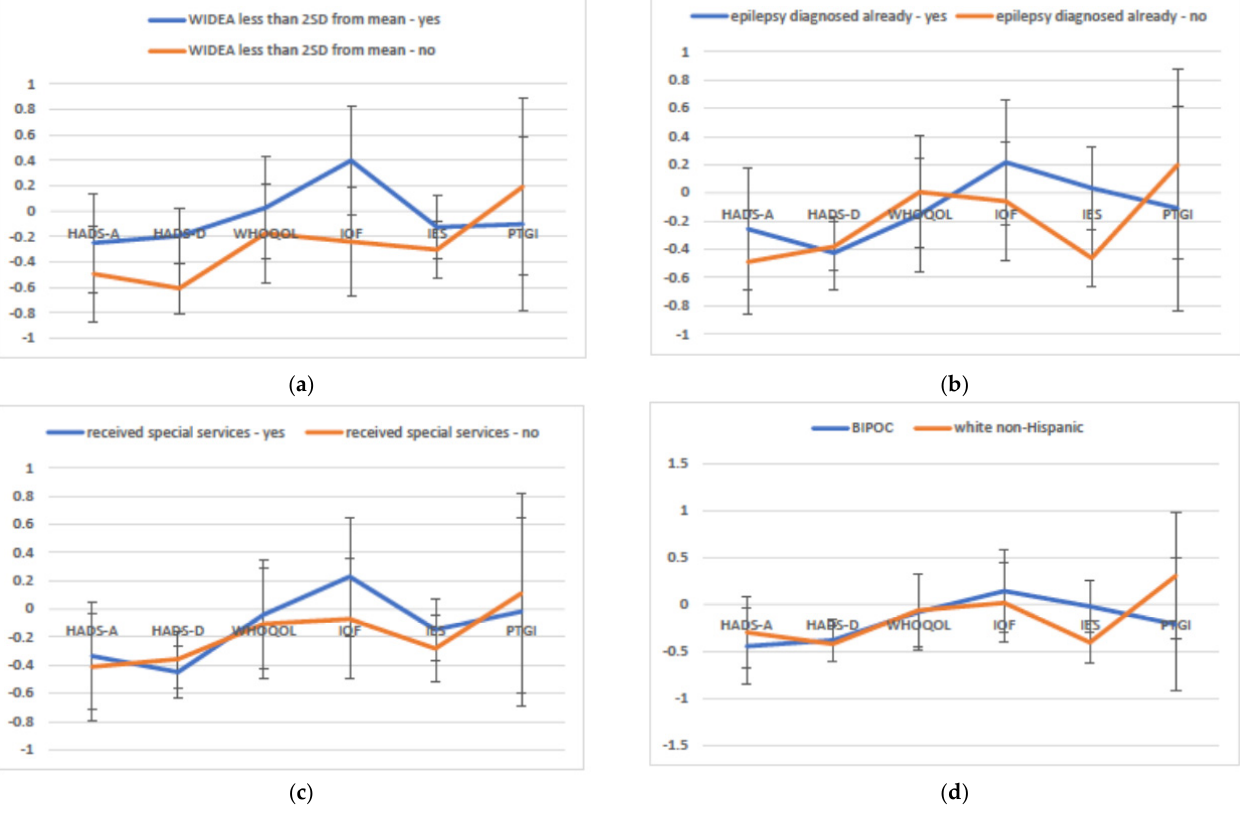
Figure 2. Adjusted mean Z-scores for the variables with significant interactions across the parent mental health and family coping outcomes. Note: The connecting lines are included to make it visually easy to see if the results are the same across outcomes (i.e., the lines are parallel) or if the ordering of the exposure groups changes (i.e., the lines cross). ( a ) Outcomes by child functional impairment (WIDEA-FS > 2 standard deviations below the mean) averaged over all time points ( p < 0.001); ( b ) Outcomes by child diagnosis of epilepsy averaged over all time points ( p < 0.0001); ( c ) Outcomes by child receiving developmental support services averaged over all time points (P = 0.002); ( d ) Outcomes by child race/ethnicity averaged over all time points ( p < 0.0002). HADS = Hospital Anxiety and Depression; IES = Impact of Events; PTSD = Post-Traumatic Stress Disorder; IOF = Impact on Family; WHOQOL-BREF = World Health Organization Quality of Life Brief Assessment; WHOQOL-BREF;PTGI = Post-Traumatic Growth Inventory; Warner Initial Developmental Evaluation of Adaptive and Functional Skills; BIPOC = Black, Indigenous, People of Color.